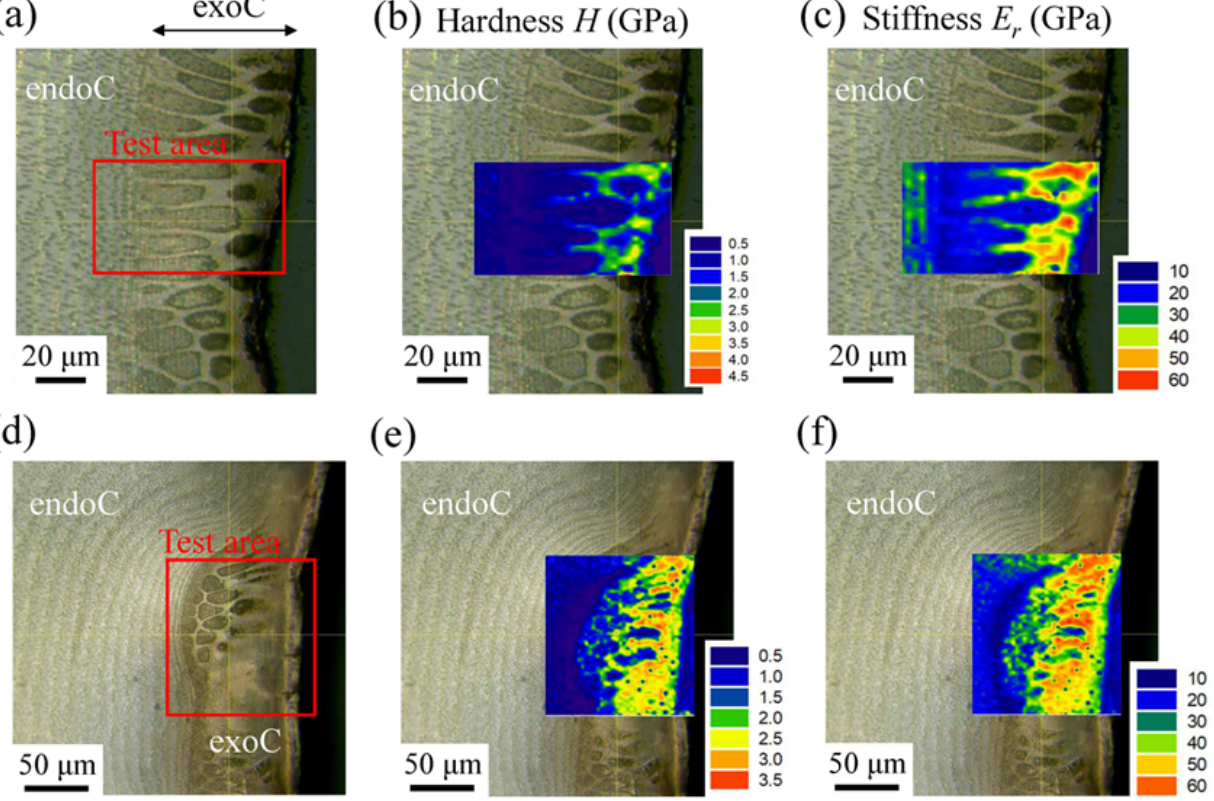
Figure 12. ( a ) OM showing the area near the mottled, deep-blue surface, including the nanoinden- tation test area, and contour maps of the ( b ) hardness, H , and ( c ) modulus, E r , inside the exocuticle (maximum force = 0.5 mN, loading time = 0.5 s). ( d ) OM showing at the other exocuticle, and contour maps of the ( e ) H and ( f ) E r . Here, the test areas in ( a , d ) are 74 × 42 μ m (38 × 22 = 836 points) and 108 × 116 μ m (55 × 59 = 3245 points), respectively.